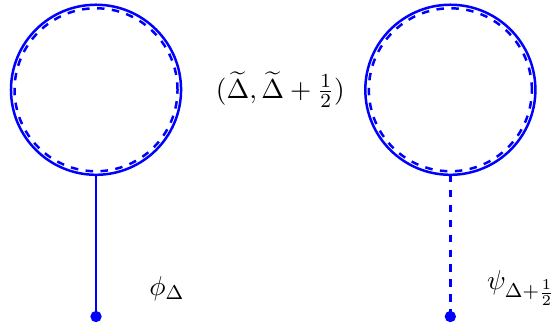
Figure 1 . One-point superconformal blocks of the supermultiplet ( (cid:30) (cid:1) ; lines stand for Grassmann even (odd) operators. The left and right tadpole graphs correspond to the lower block (3.4) and upper block (3.5) and solid-dashed loop represents taking the